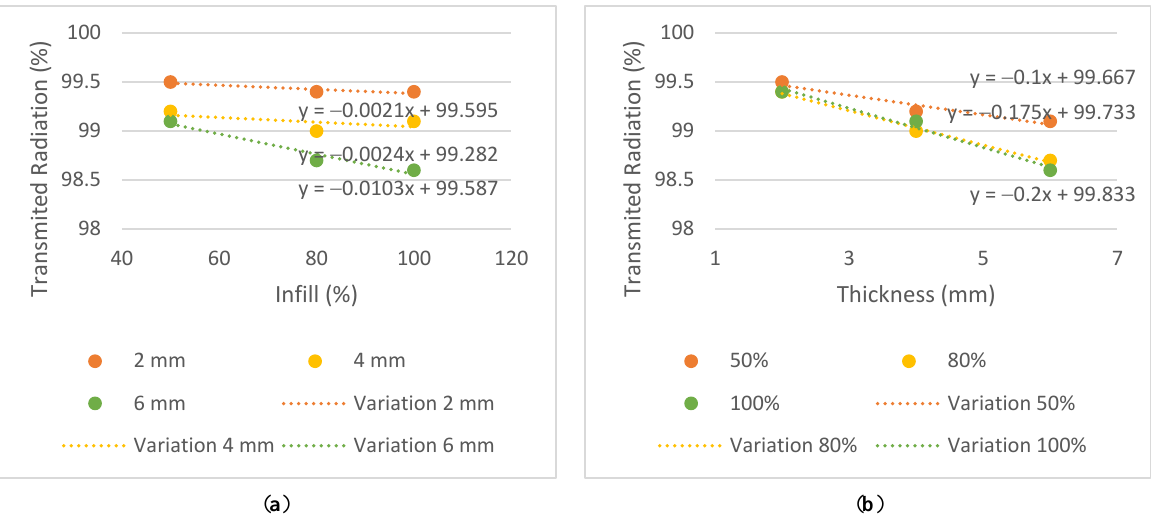
Figure 7. Variation of the transmitted radiation, in %, for the energy of 10 MV, ( a ) by infill and ( b ) by thickness.